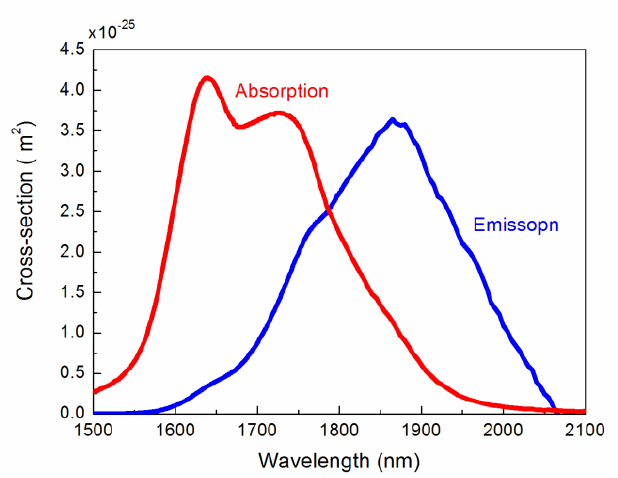
Figure 2. Measured absorption and emission cross-section spectra of the Tm 3+ -doped silicate